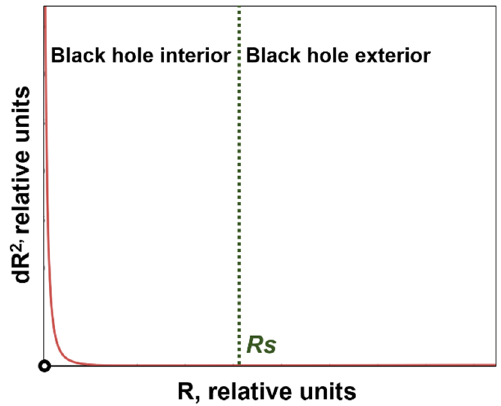
Figure 1. Black hole singularity exclusion zone. Relative uncertainty, dR 2 , in the radiial coordinate ( R ) as a function of R (Equation (36)). The uncertainty diverges to infinity towards the singularity ( R = 0). Geodesics with dR 2 values below the curve are not allowed, and define a particle exclusion zone in the interior of the black hole.